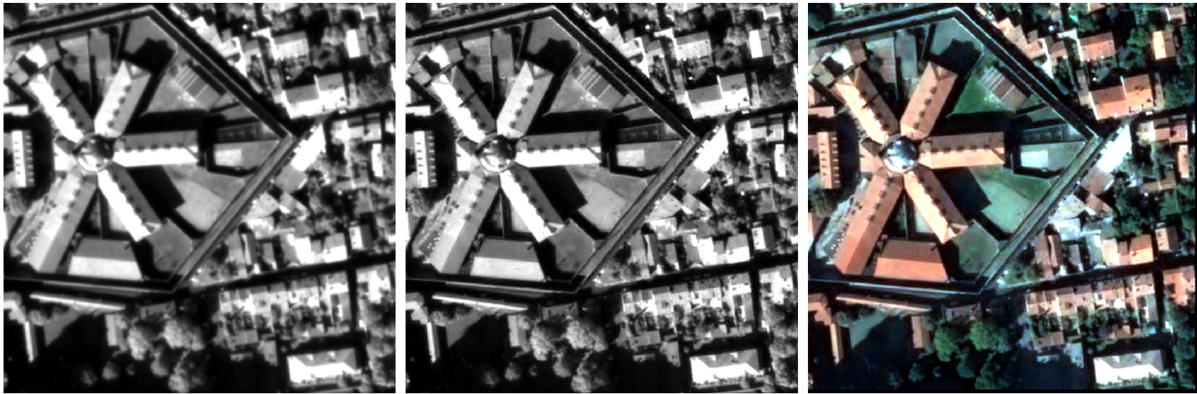
Figure 4. Restoration of a Pleiades HR image over Toulouse at a 70cm resolution on the ground. ( Left ) Raw decompressed image, ( Centre ) Noise restored, denoised and deconvolved image ( Right ) Pan-sharpened image using R, G and B channels at 2.8m resolution.